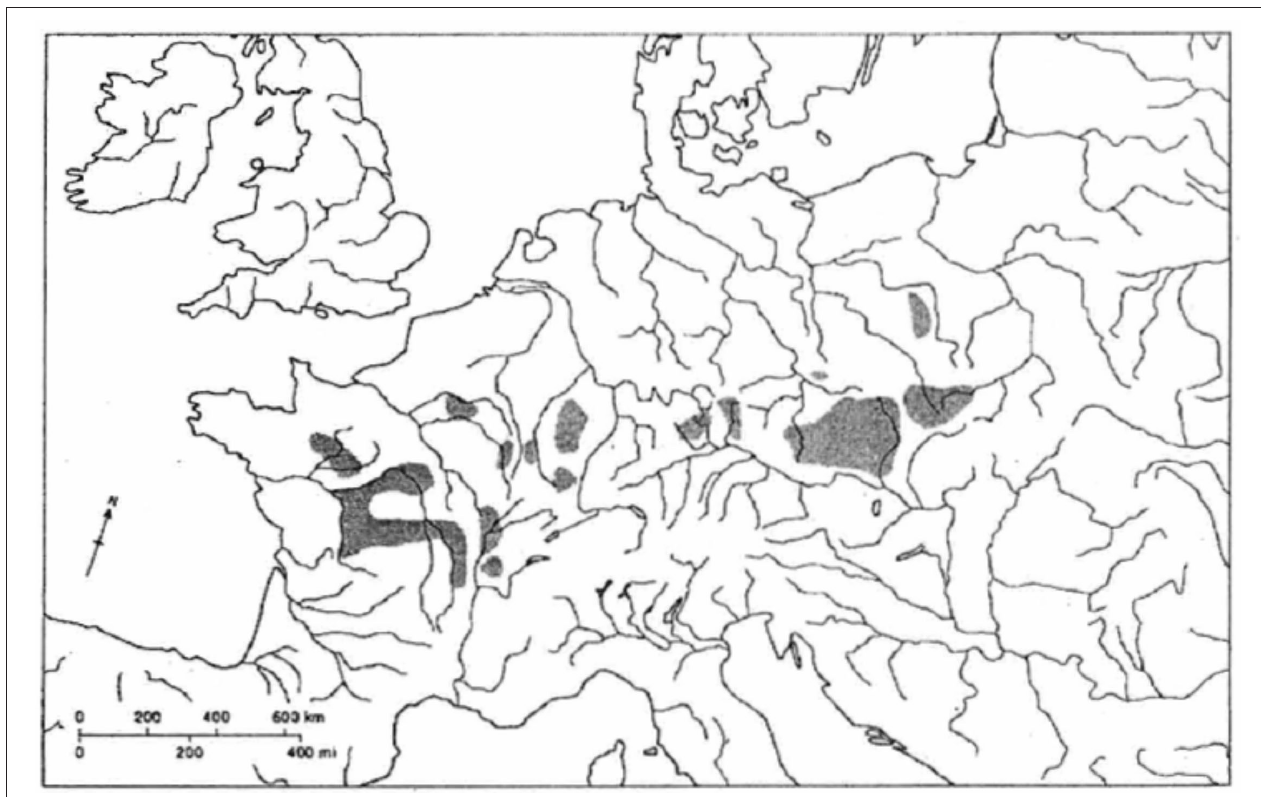
FIGURE 3 | Major regions of carp aquaculture by the end of the Medieval. From Hoffmann (2002) and Hoffmann and Winiwarter (2010). Reproduced with permission from the author (R. C. Hoffmann).